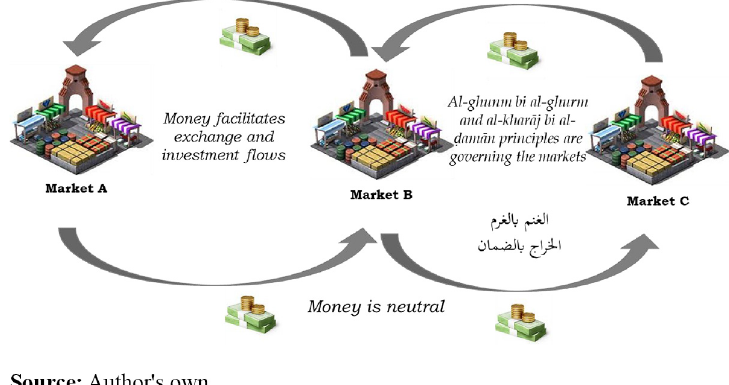
Figure 3. Scenario 2 – a rib (cid:1) a - free economy with